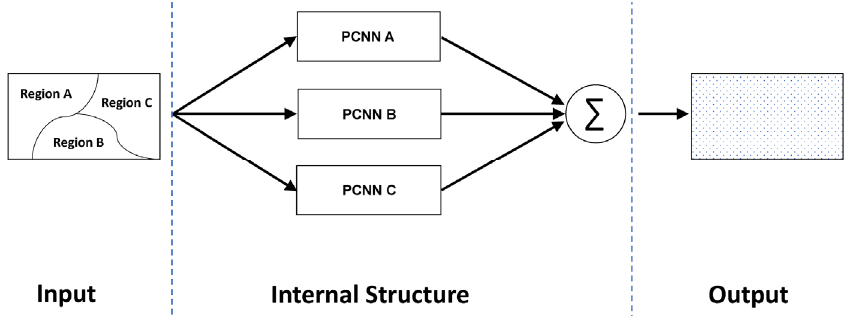
Figure 3. Structure of group-isolated HPCNN.